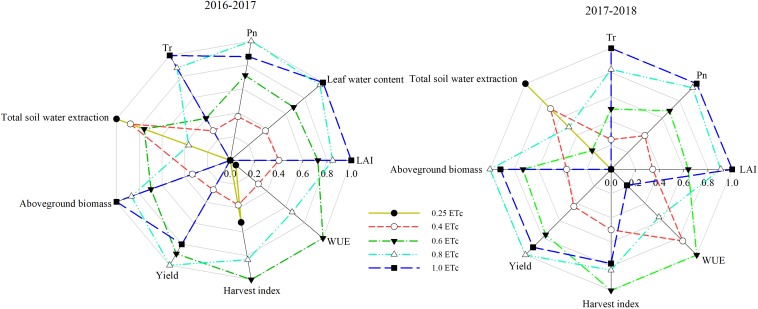
The radar chart demonstrating winter wheat performance under effect of different irrigation treatments.